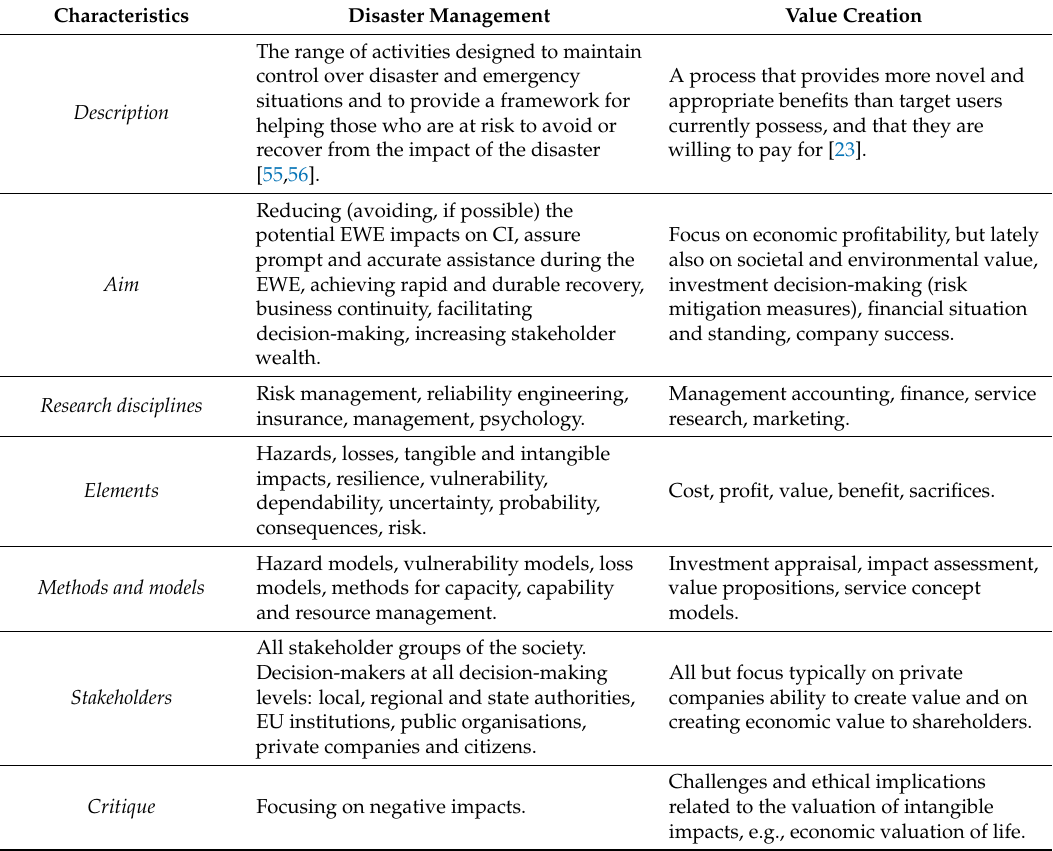
Table 1. Features of value creation and disaster